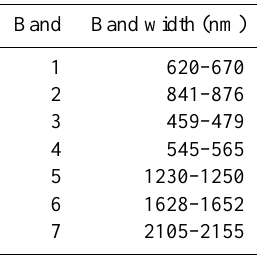
Table 2. Description of the seven spectral bands of MODIS images used in this